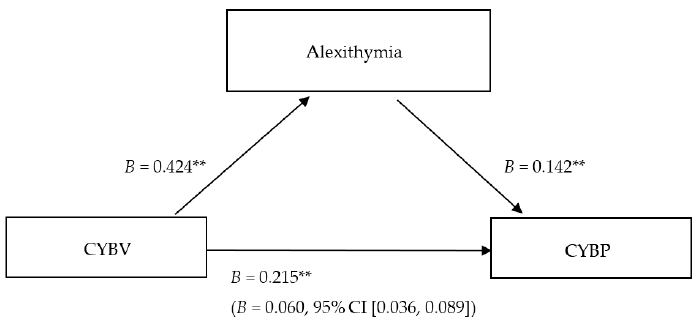
Figure 1. Direct and indirect effects of cyberbullying victimization (CYBV) and alexithymia on